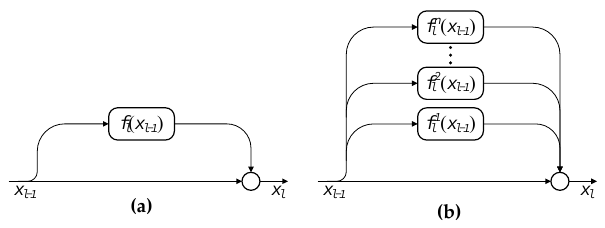
Figure 3. Different residual block architectures. ( a ) Original residual block containing one residual function. ( b ) Multipath residual block consisting of multiple residual